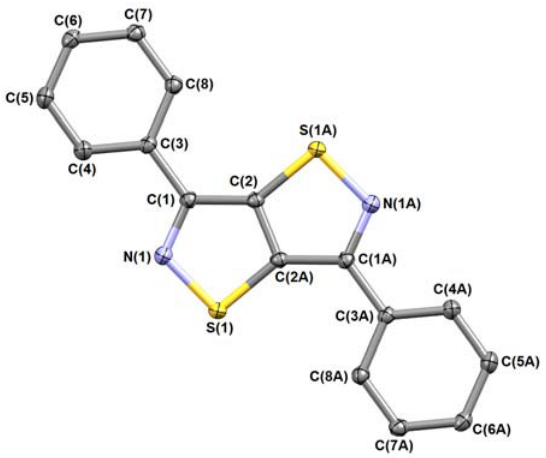
Figure 3. X ‐ Ray structures of ( E ) ‐ 4,4 ′‐ diphenyl ‐ 5,5 ′‐ bi(1,2,3 ‐ dithiazolylidene) ( 11b ) (CCDC 1840072) Figure 3. X-ray structures of ( E )-4,4 (cid:48) -diphenyl-5,5 (cid:48) -bi(1,2,3-dithiazolylidene) ( 11b ) (CCDC 1840072) ( top ) and 3,6 ‐ diphenylisothiazolo[5,4 ‐ d ]isothiazole ( 8b ) (CCDC 1840071) ( bottom ). Thermal ( top ) and 3,6-diphenylisothiazolo[5,4- d ]isothiazole ( 8b ) (CCDC 1840071) ( bottom ). Thermal ellipsoids ellipsoids are at 50% probability and hydrogens are omitted for clarity. are at 50% probability and hydrogens are omitted for